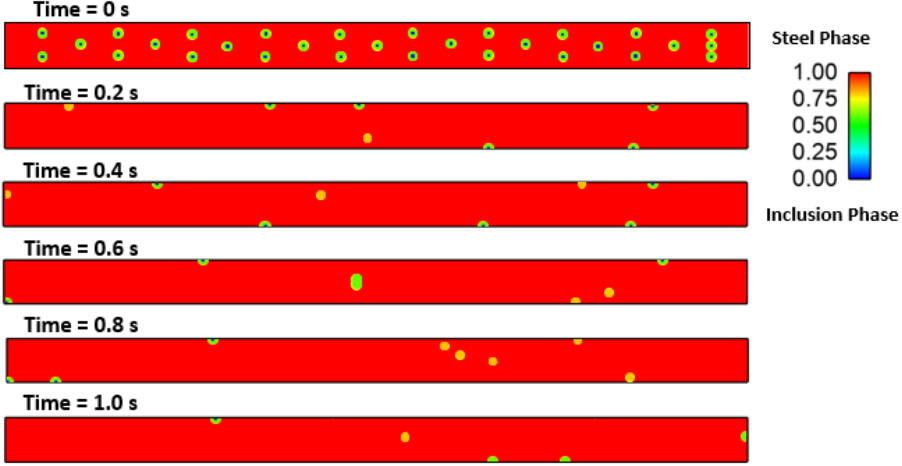
Figure 7. 4.29: Motion of alumina inclusion during solidification (initial temp: 1893 K, sulfur: 40 PPM).